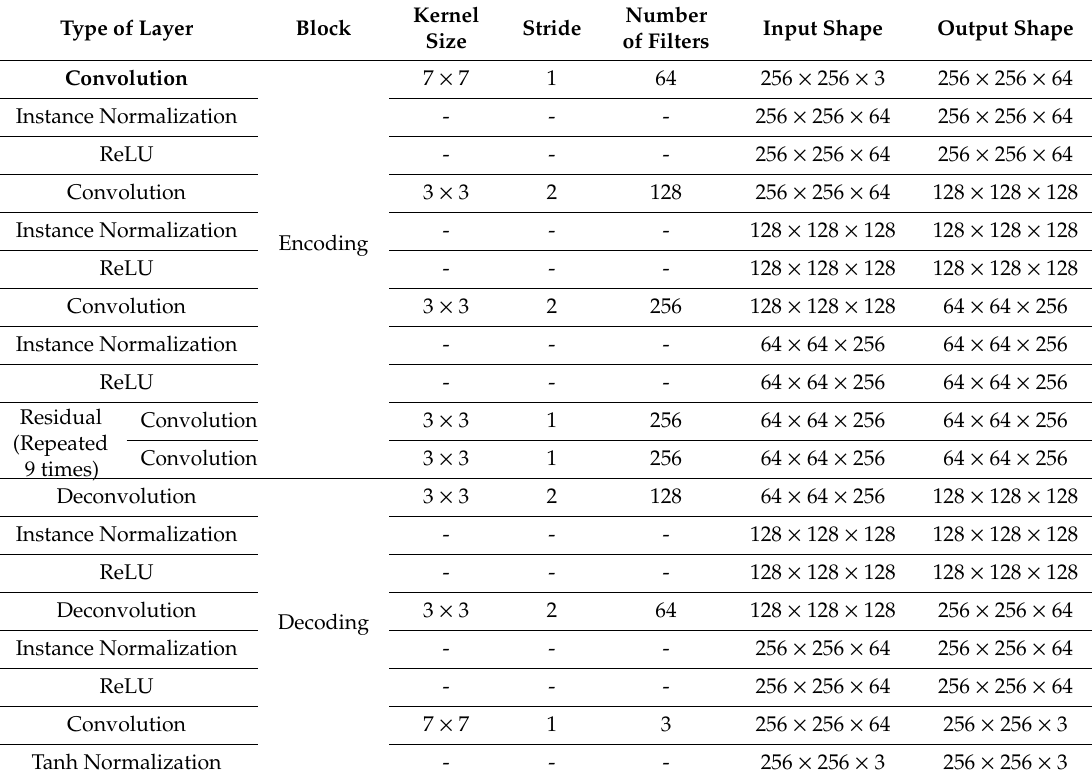
Table 3. Detailed description of the generator network used in our study (input and output shape is in format: height × width ×